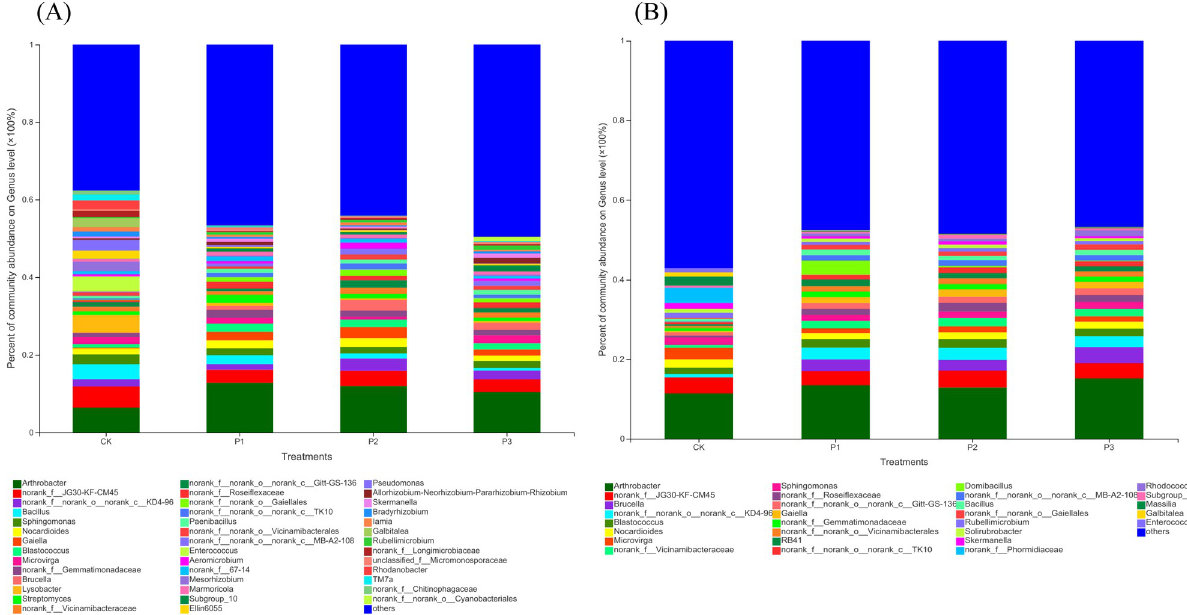
Fig 3. Bacterial community composition based on Genus level. A is 0–30 soil layer, B is 30–60 cm soil layer.